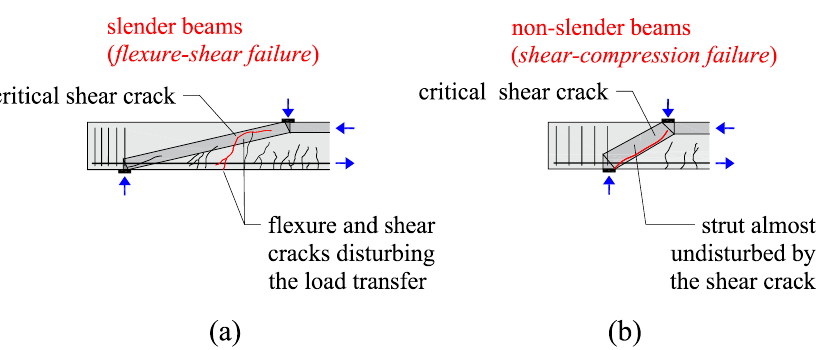
transfer in the fictitious strut between the load and the support. On the other hand, when by a strut, which is named herein as arching action. the concentrated loads are placed closer to the support (Figure 6b), the members fail in shear-compression, and direct load transfer between the load and the support can occur by a strut, which is named herein as arching action.